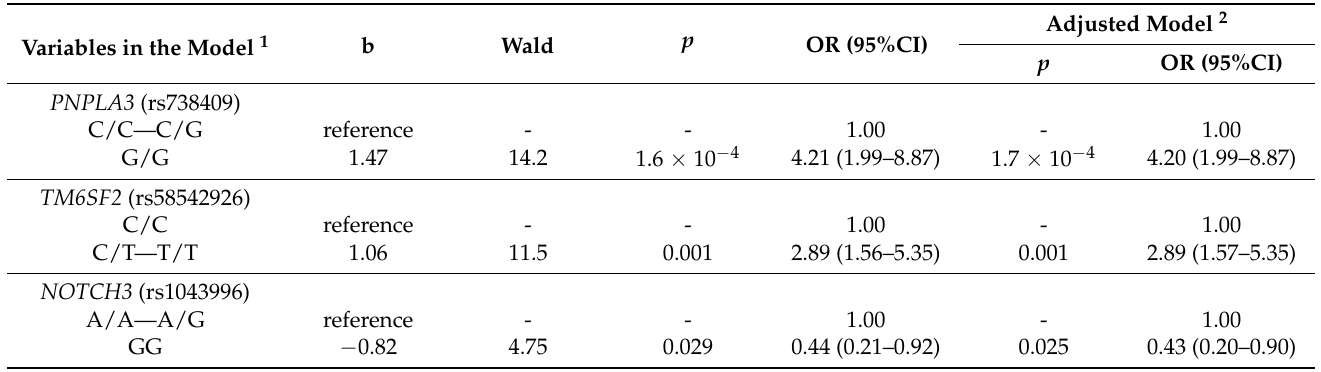
Table 3. Logistic regression analysis of predictors of cirrhosis